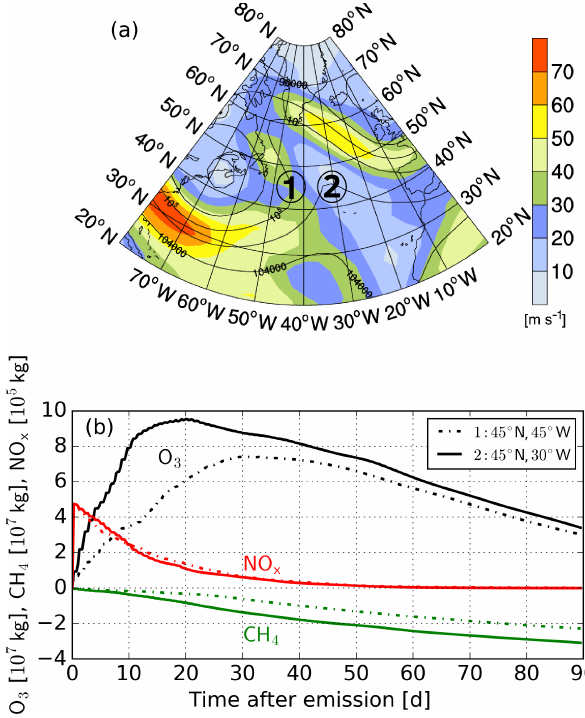
Figure 1. (a) Weather conditions at time of emission represented by geopotential height (black contours in gpm) and wind velocities (see colour bar, in ms − 1 ) at 250hPa. (b) The global composition changes in O 3 and CH 4 induced by the emitted NO x at two emis- sion